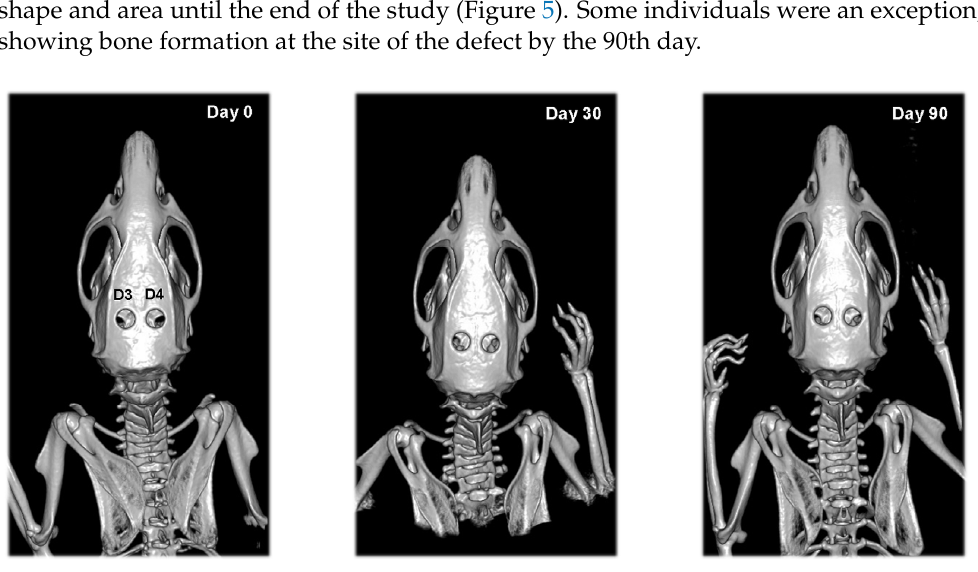
Figure 5. Serial 3D CT scans of calvarial bones of rats from the second experimental group after collagen cone and i.p. EPO injection (D3) and empty defect and i.p. EPO injection (D4) on post- operative days 0, 30 and 90.